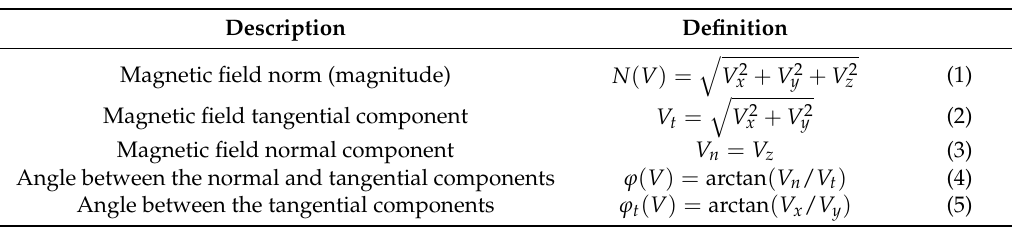
Table 1. Magnetic vector field expression modes.